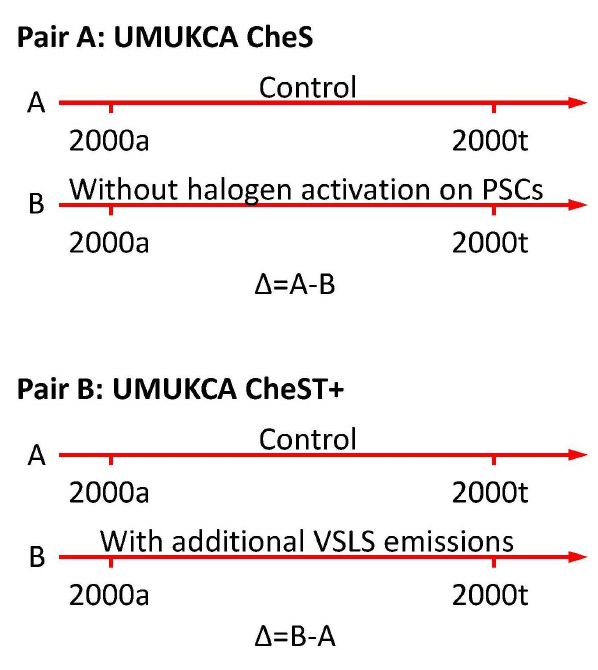
Fig. 2. Summary of the two pairs of experiments. Pair A compares integrations with and without halogen activation on PSCs. Pair B compares integrations with and without additional halogenated species emissions. The differences ( 1) are defined in a way that the run with generally higher ozone is subtracted from the run with lower ozone. See Fig. 3 for total ozone changes. Note that the runs are time slice integrations, and consecutive model years are for the same year 2000 boundary conditions. However, the individual years in each run differ due to internal variability as indicated by the let- ters behind all “2000” time-line